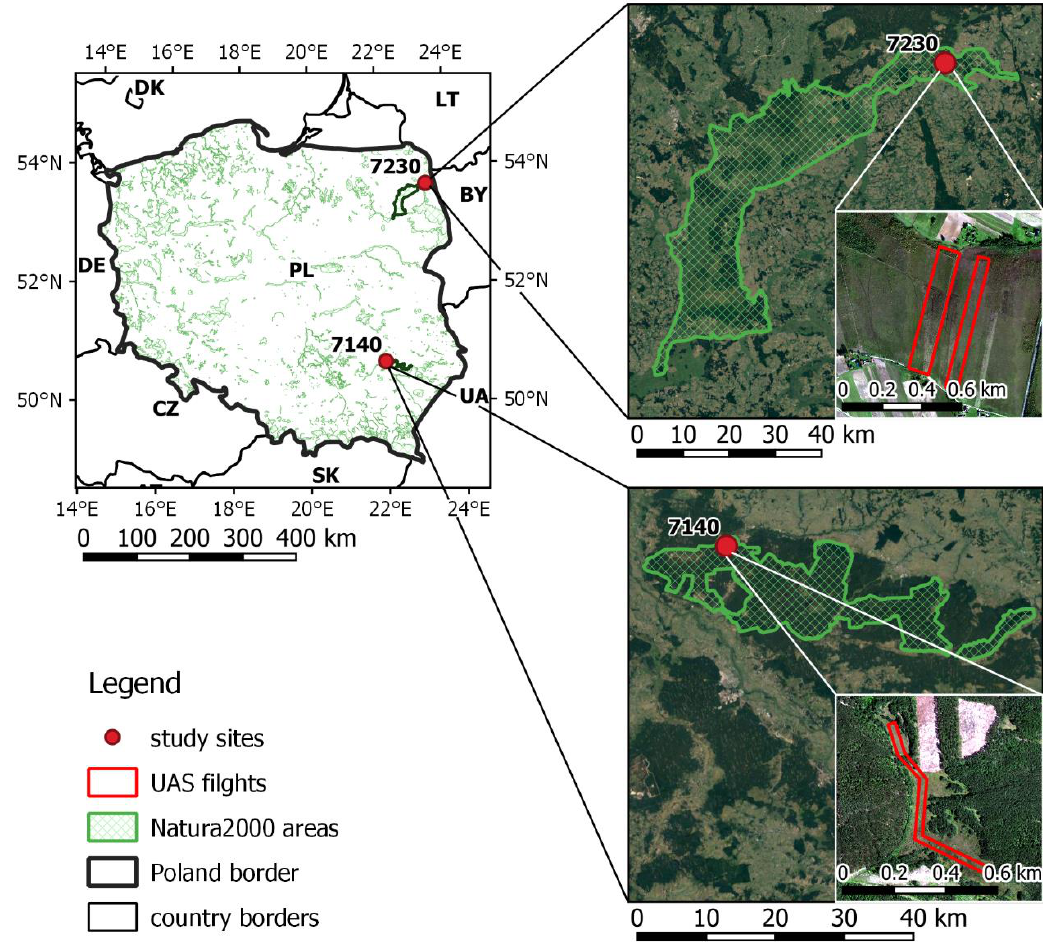
Figure 1. Study sites location on Natura 2000 area map of Poland.